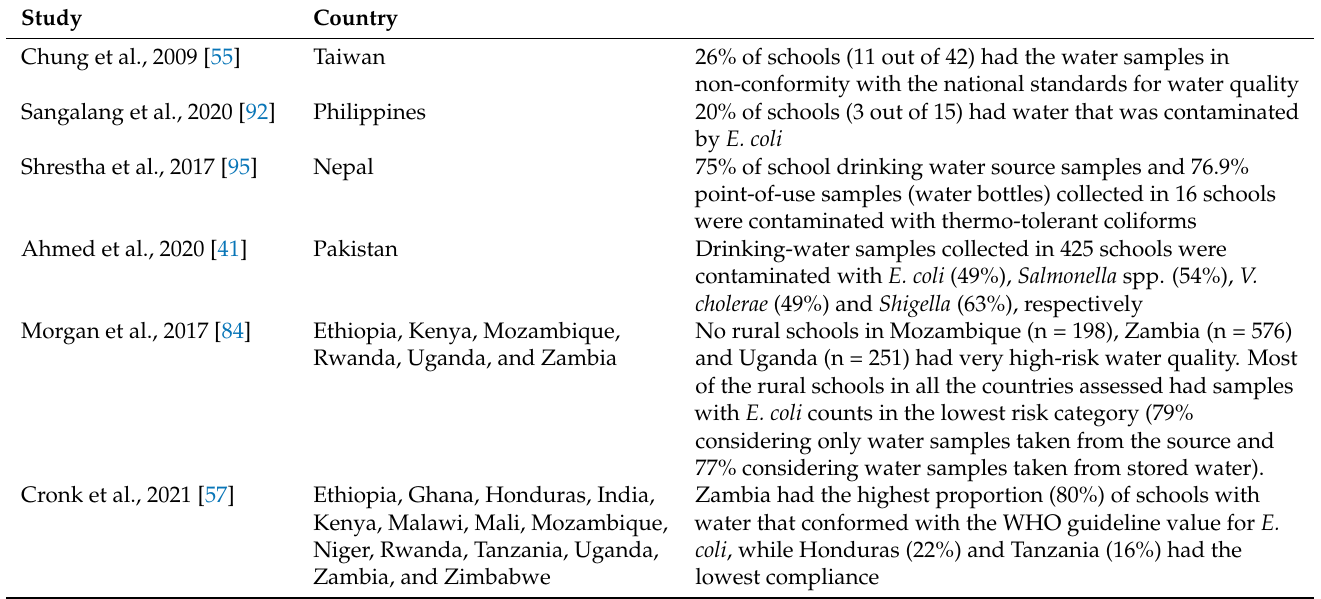
Table 4. Water quality reported in schools based on a review of the literature (n = 65